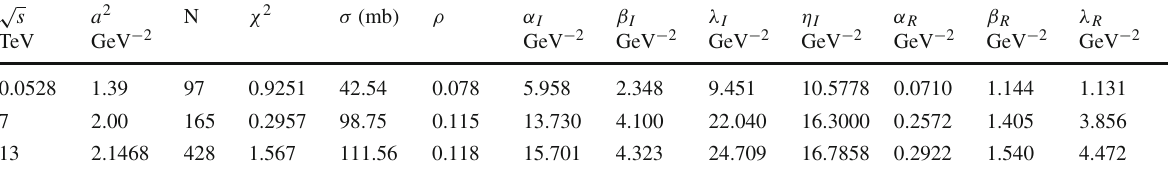
Table 5 Parameters of the amplitudes in the KFK model determined at the energies 52.806 GeV, 7 TeV and 13 TeV. For uniformity, the table uses the alternative parameters η K = a 2 γ K with units GeV − 2 instead